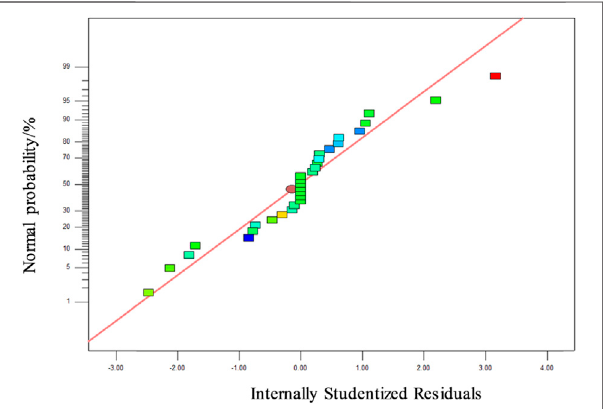
FIGURE 11 | Contrast Diagram between Actual and Prediction Value of